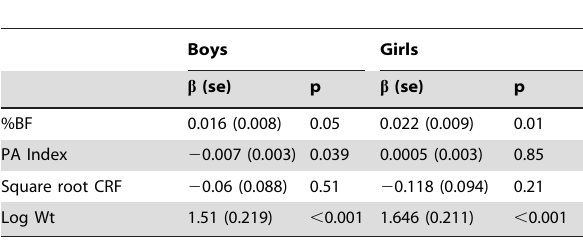
Table 2. The longitudinal (within-child) relationships between HOMA-IR and explanatory variables percent body fat, physical activity, cardiorespiratory fitness and body